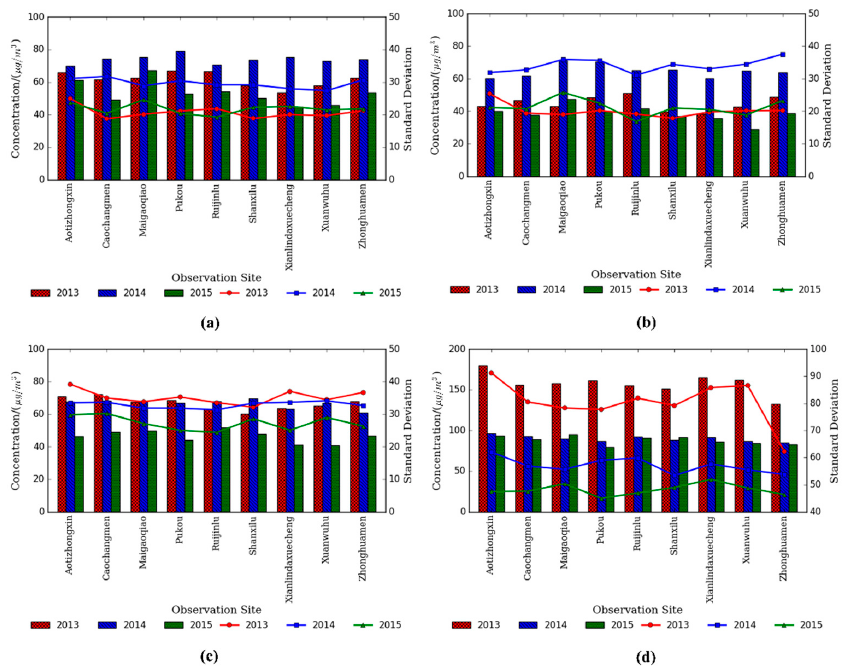
Figure 3. Seasonal variation of PM 2.5 concentrations for the past three years in Nanjing. The bar represents the concentration of PM 2.5 and the line means standard deviation; ( a ) Spring; ( b ) Summer; ( c ) Autumn and ( d ) Winter.